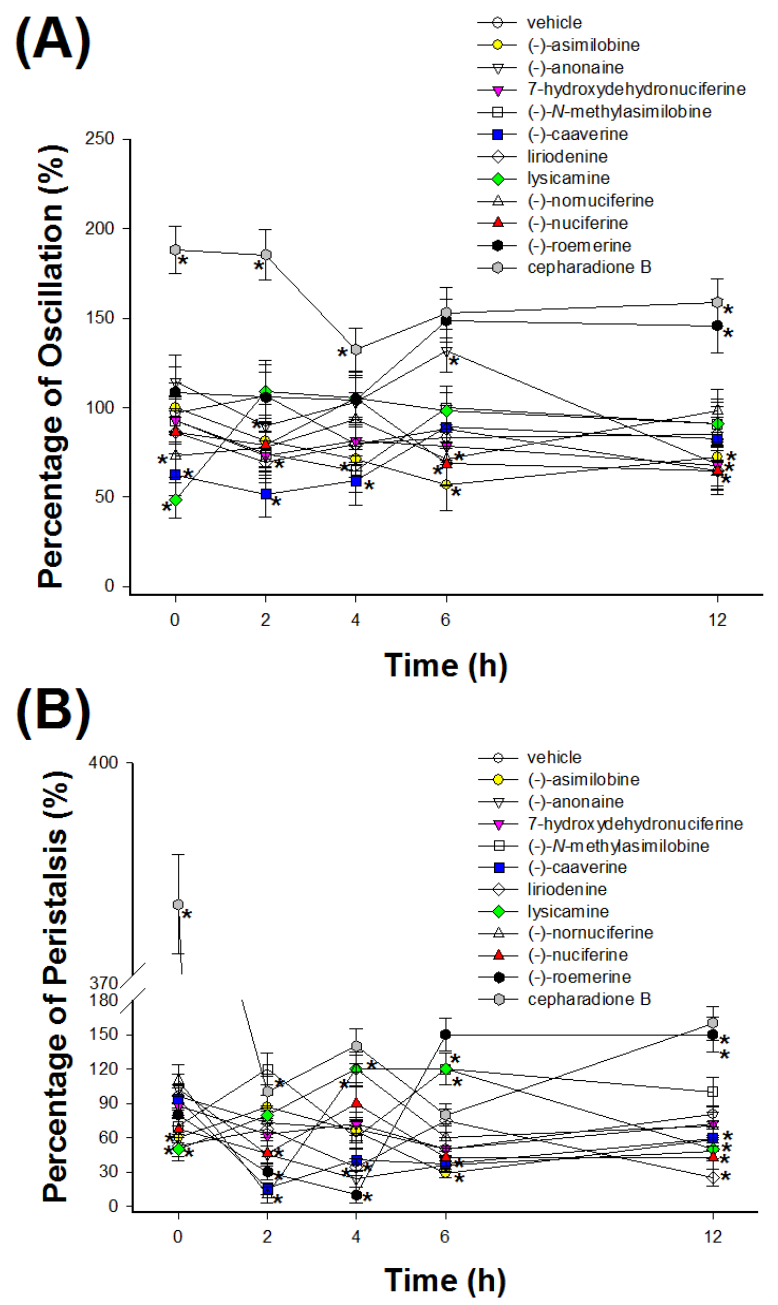
Figure 3. Effect of chemical constituents of Nelumbo nucifera Gaertn. cv. Rosa-plena . on H. nana . Treatment of liriodenine ( 1 ), lysicamine ( 2 ), (-)-anonaine ( 3 ), (-)-asimilobine ( 4 ), (-)-caaverine ( 5 ), (-)- N -methylasimilobine ( 6 ), (-)-nuciferine ( 7 ), (-)-nornuciferine ( 8 ), (-)-roemerine ( 9 ), 7-hydroxydehydronuciferine ( 10 ) and cepharadione B ( 11 ) (100 μ M) with incubation times of 2, 4, 6 and 12 h on H. nana , respectively. Time course of effect on oscillation ( A ) and peristalsis ( B ) of H. nana on test compounds presented as percentages. Vehicle is 0.1% DMSO solvent. Each value is presented as mean ± SD of three individual experiments; * p < 0.05 indicates a significant difference from the result for vehicle-treated